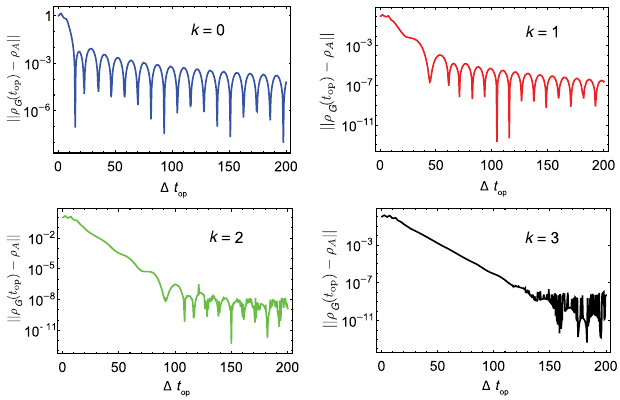
− ρ ∥ against braiding period t A G ð op Þ